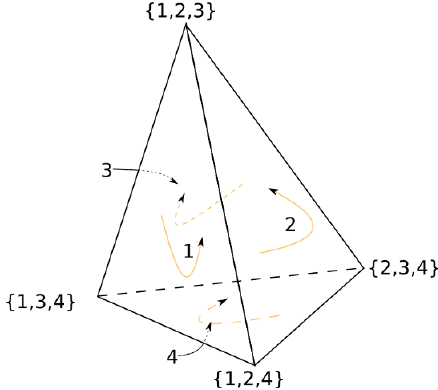
Figure 6 . A depiction of a three-simplex bounded by four CP 2 ’s, and described by a cyclic list on each